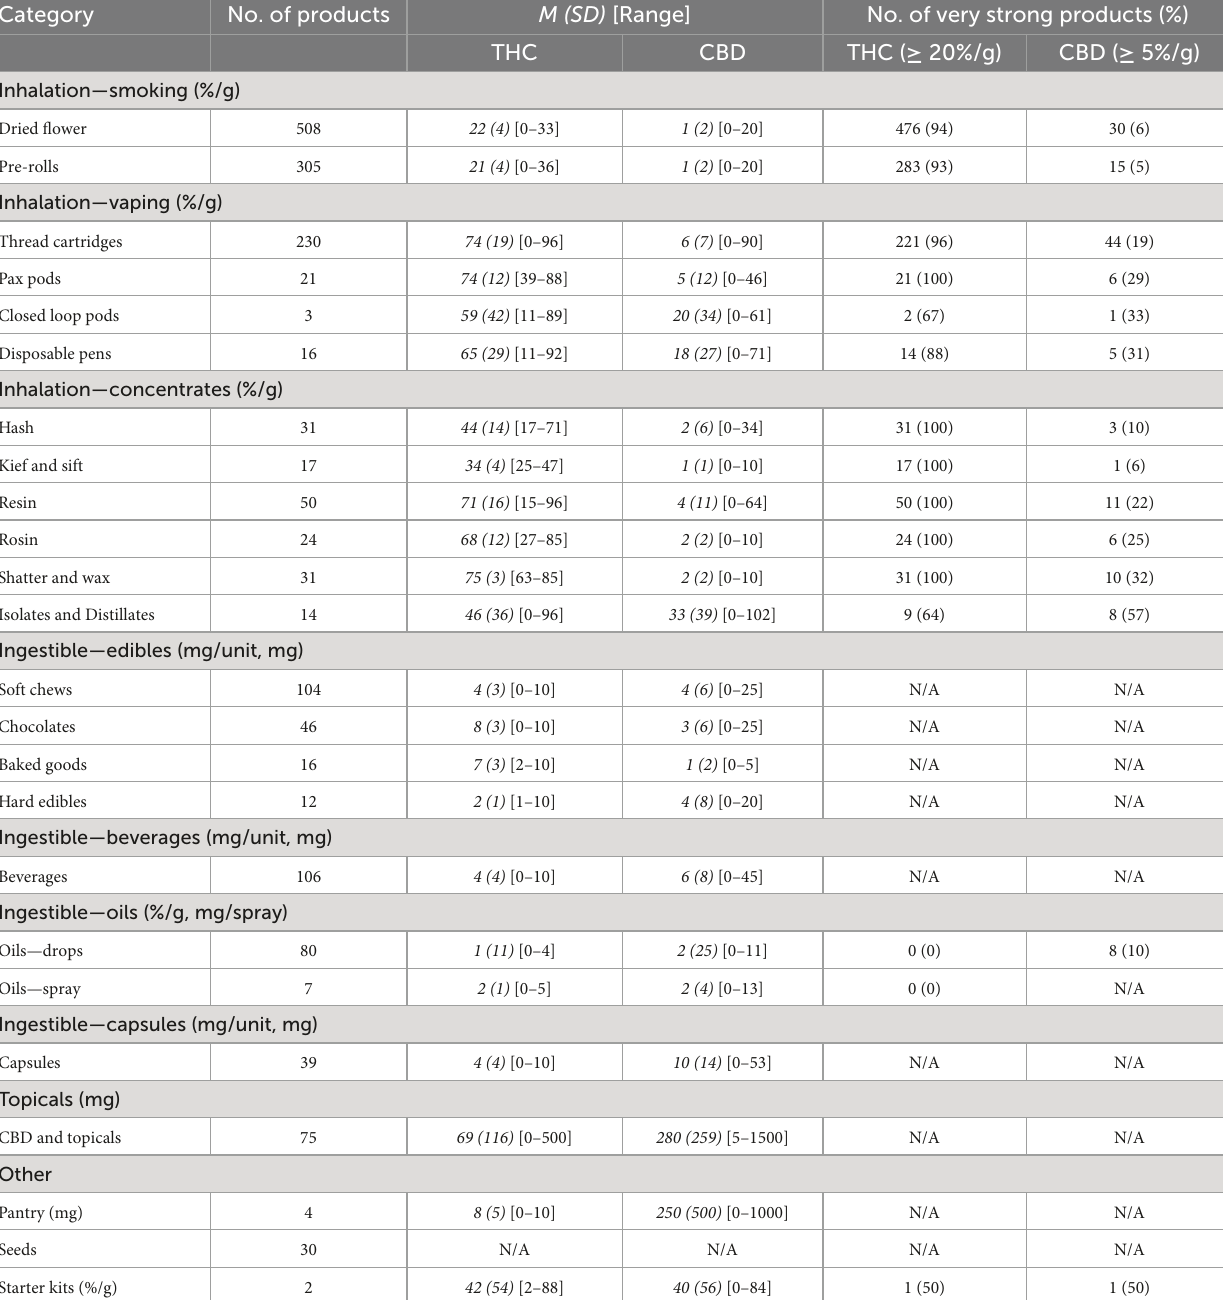
TABLE 2 Tetrahydrocannabinol (THC) and cannabidiol (CBD) potency by product type (first quarter of 2022).